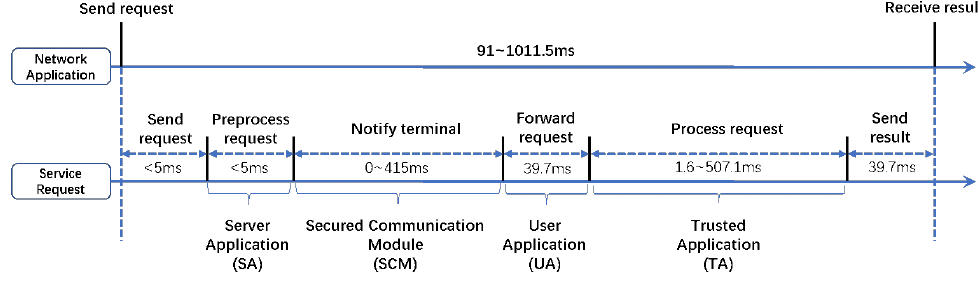
Figure 3. Overhead Imposed by BioShare in Processing a Service Request with Forwarding